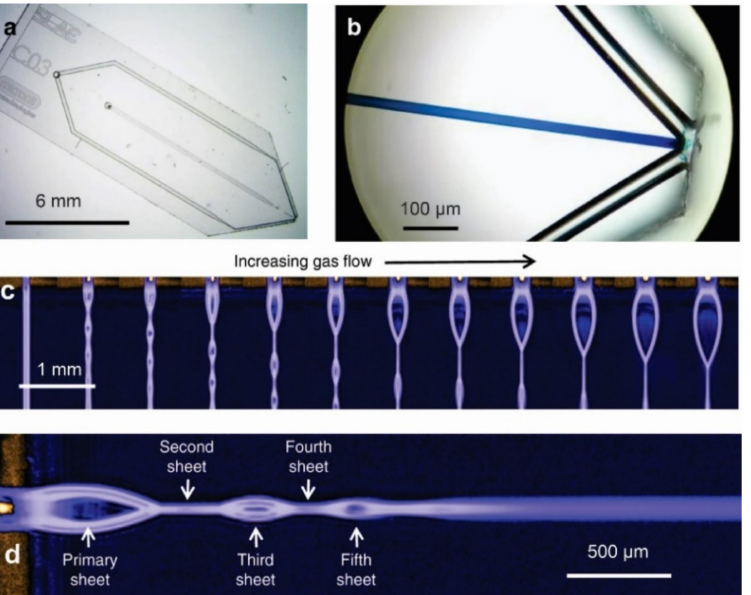
Figure 5. Microfluidic GDVN for ultrathin liquid sheet generation. ( a ) The microfluidic chip (6 × 19 mm) with gas and liquid ports incorporated, ( b ) liquid and gas microchannel can be distin- guished via the introduction of blue dye into the liquid channel, ( c ) the jet regime varies as a function of gas pressure, ( d ) a detailed view of the alternating orthogonal liquid sheet structure (reproduced with permission from Reference